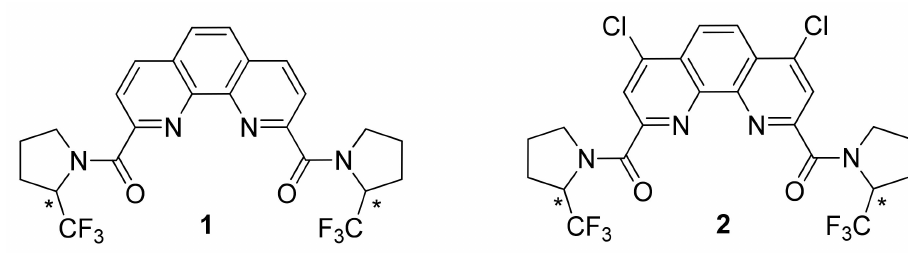
Figure 1. Trifluoromethylated phenanthrolinediamides 1 and 2 . Chiral centers marked with